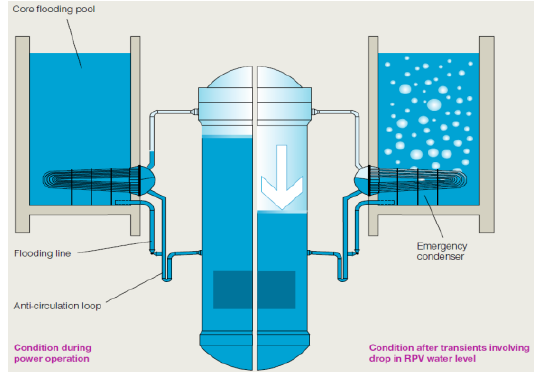
Fig. 1. Operation scenarios of the Emergency Condenser.